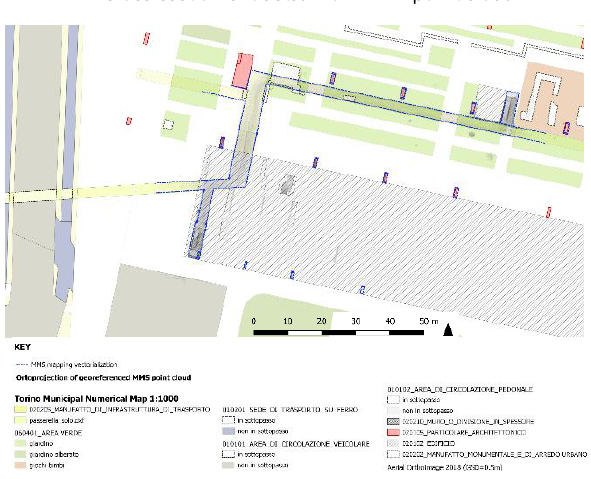
Figure 9. The comparison between digital mapping 1:1000 and dense cloud plan derived from ZEB Revo (blue vector), for mapping and building scale updating